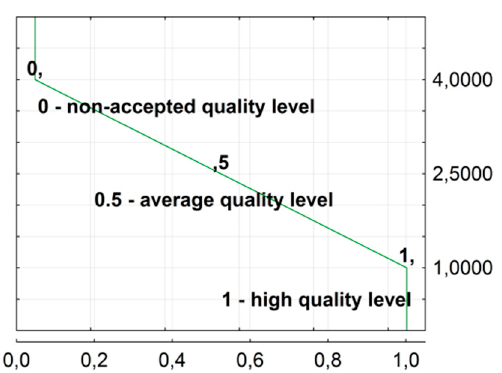
Figure 10. Example of a utility profile based on the ageing index IS. Table 8. Limiting ranges of utility profiles.